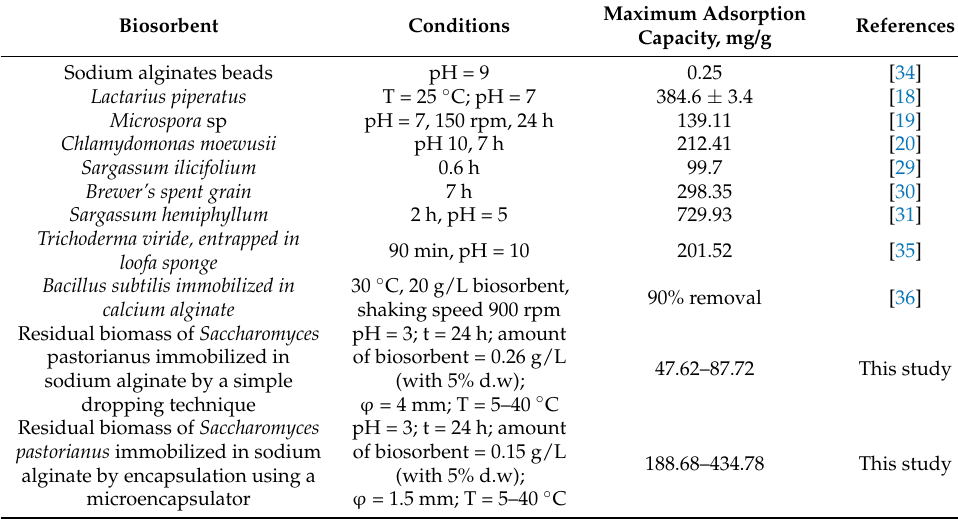
Table 3. Applications of various microbial biomass-based biosorbents immobilized form for methy- lene blue dye